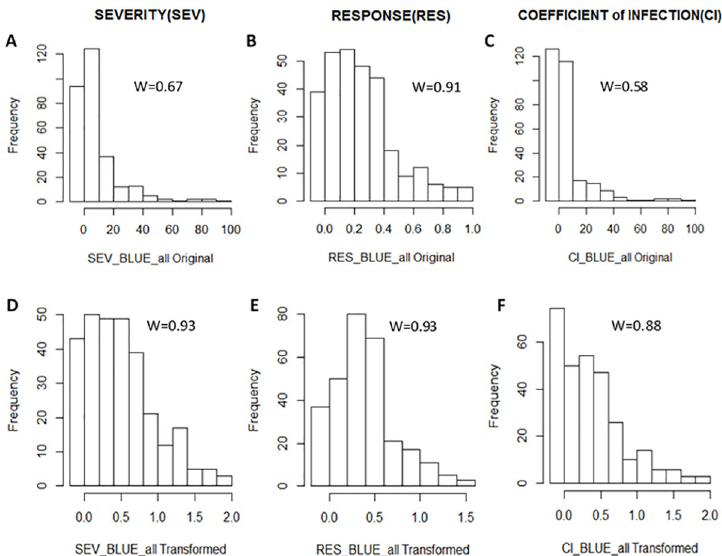
Fig 2. Distributions of disease severity (SEV), response (RES) and coefficient of infection (CI) combined over four environments. A, B and C represents distributions of best linear unbiased estimates (BLUEs) of original for SEV, RES and CI data while D, E and F represents transformed data in their respective order. “W” is Shapiro—Wilks Statistic indicating the correlation between observed values and normal scores both for the original and transformed